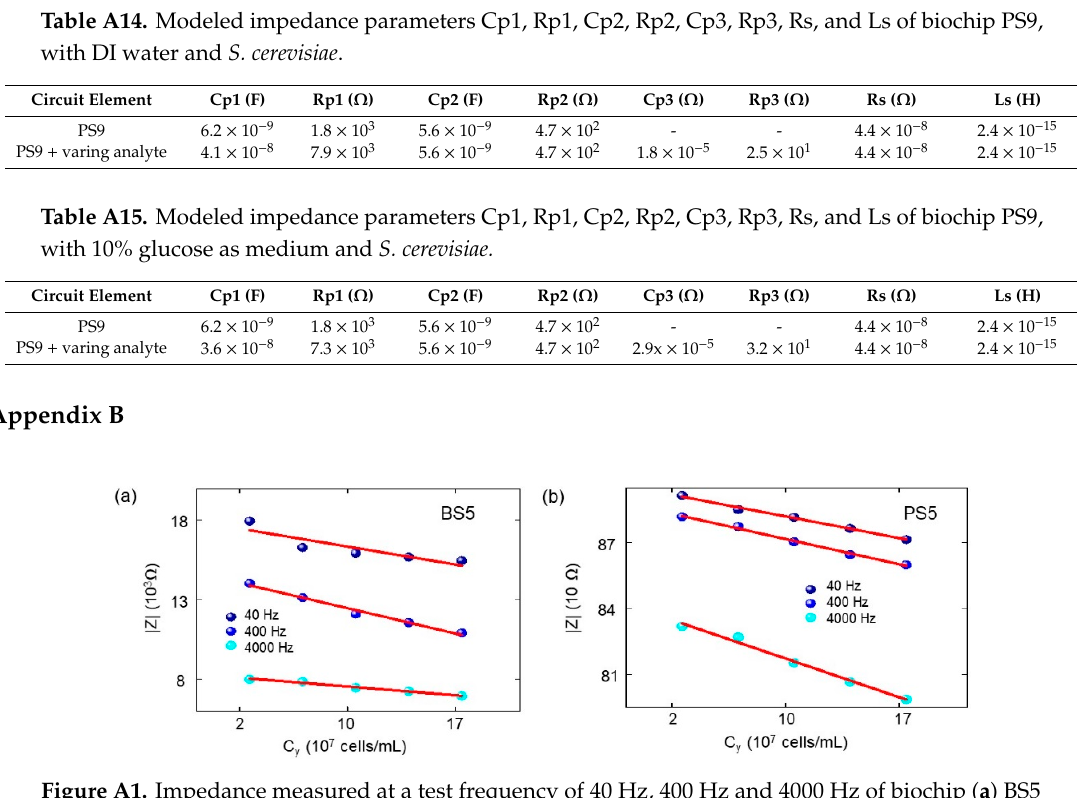
Table A14. Modeled impedance parameters Cp1, Rp1, Cp2, Rp2, Cp3, Rp3, Rs, and Ls of biochip PS9, with DI water and S. cerevisiae .